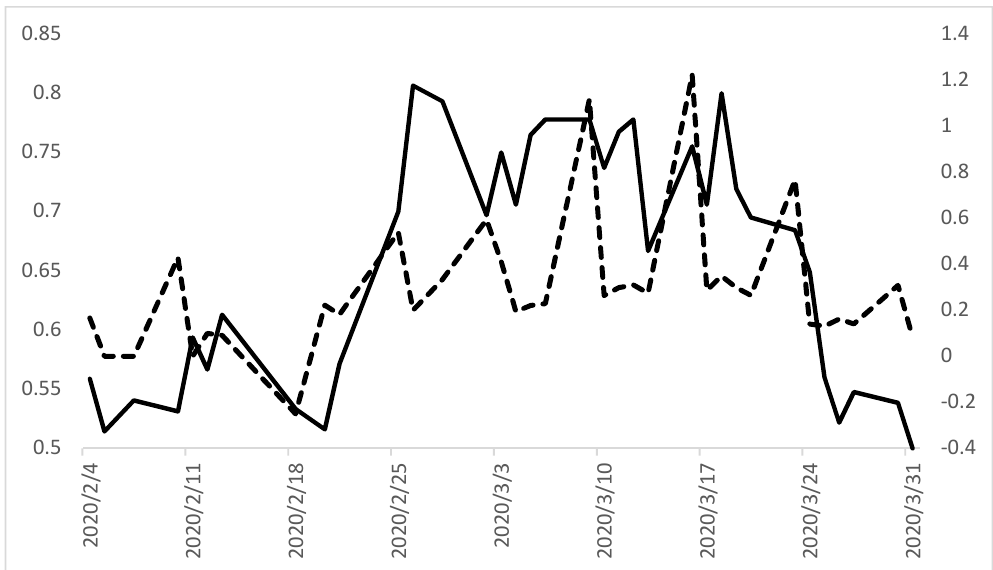
Figure 4. Aggregate ECI and COVID-19 growth in new cases. Notes: The figure plots the ECI (left axis, solid line) against the growth rate of the 7-day moving average of new COVID-19 cases (right axis, dashed line) for the period 4 February 2020 to 31 March 2020. COVID-19 case data are collected from the CDC